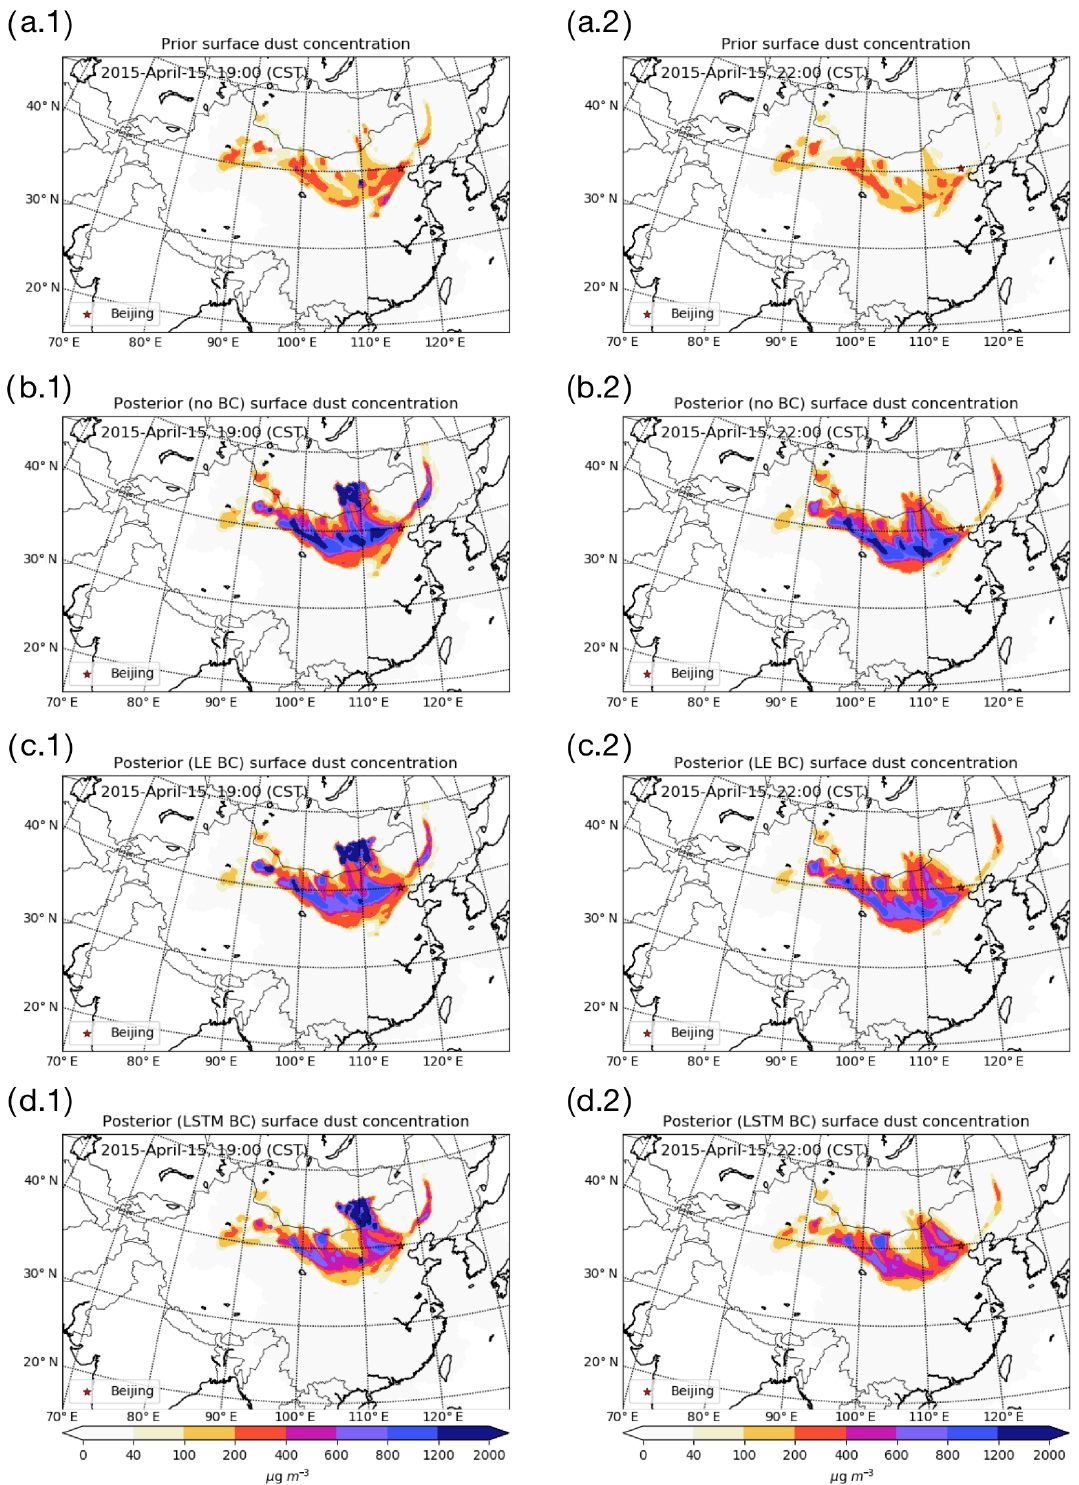
Figure 8. Surface dust concentration of a priori (a.1–a.2) , a posteriori using no bias-corrected (no BC) data (b.1– b.2) , a posteriori using LOTOS-EUROS/non-dust bias-corrected (LE BC) data (c.1–c.2) , and a posteriori using no bias-corrected (LSTM BC) data (d.1–d.2) on 15 April at 19:00 (a.1–d.1) and 22:00 (a.2–d.2)